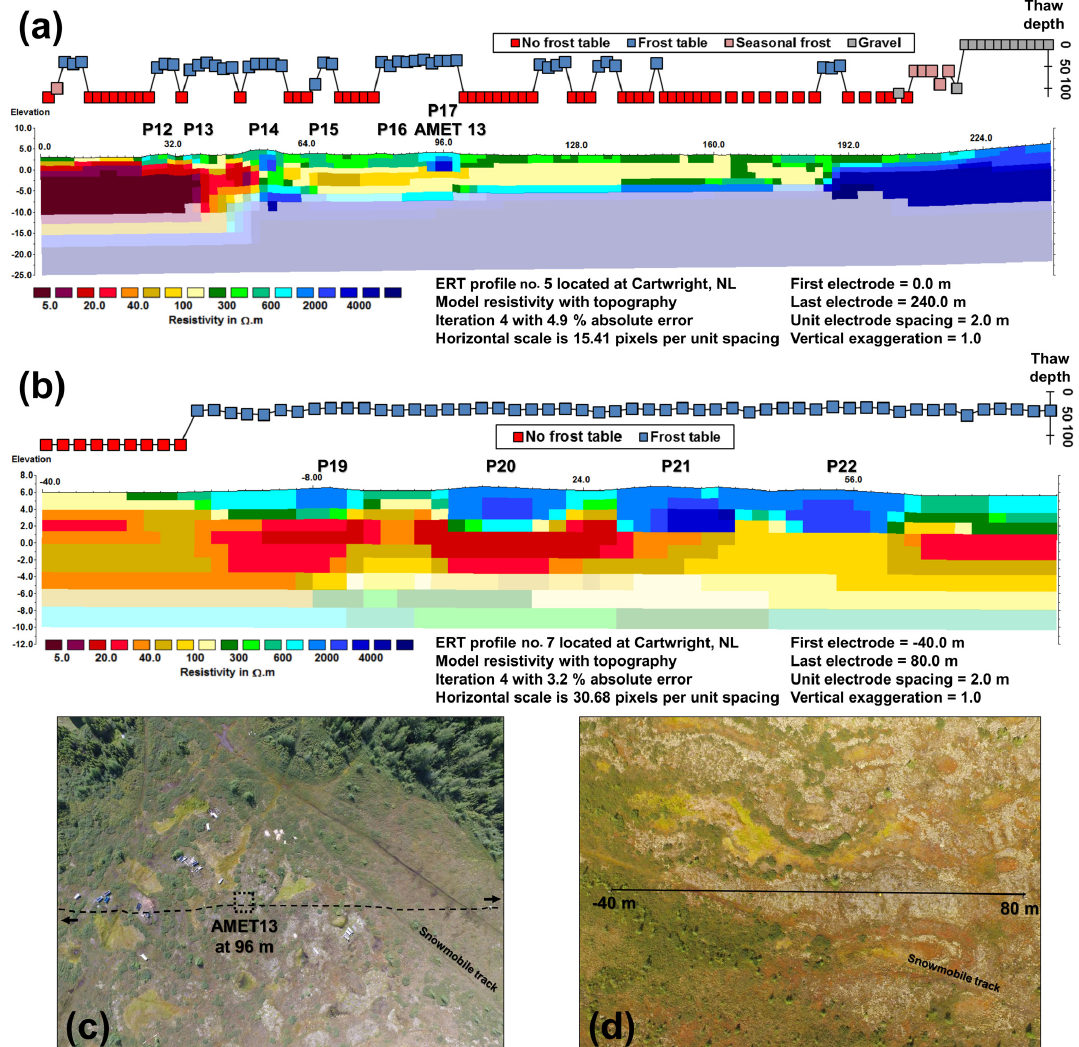
Figure 6. Peatland permafrost at Cartwright. Frost tables and modelled resistivities on (a) ERT profile 5 and (b) ERT profile 7. UAV vertical images of (c) ERT profile 5 and (d) ERT profile 7, with black lines delimiting the approximate location of the ERT survey lines and text showing the start and end